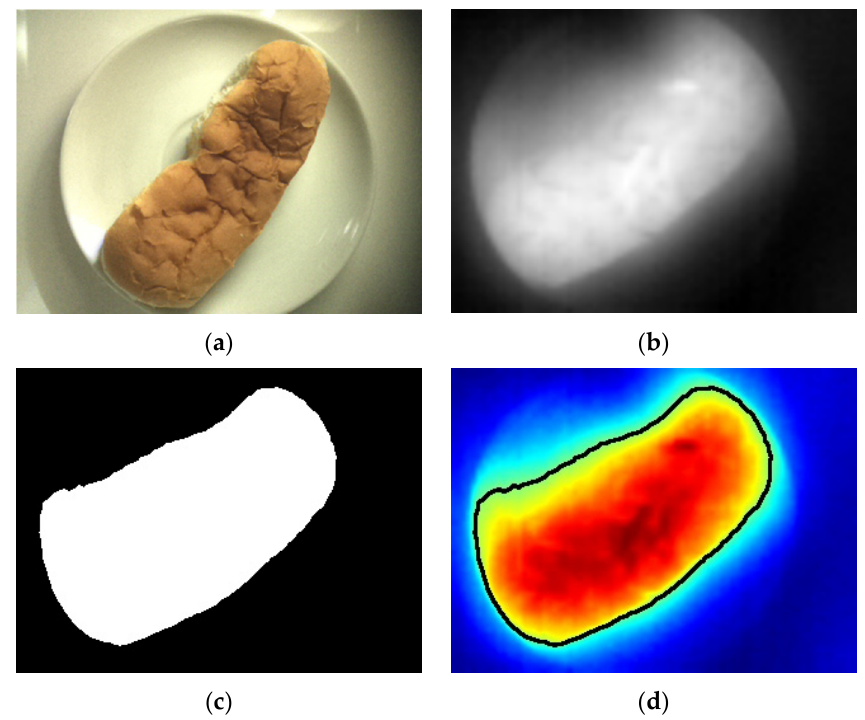
Figure 4. ( a ) Food image taken by the CMOS camera; ( b ) grayscale thermal image taken by the FLIR camera; ( c ) the mask; ( d ) colored thermal image with contour.